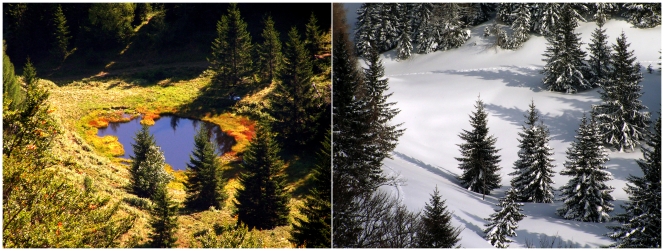
Shallow dystrophic Pond-1.This pond is persistently inhabited by the investigated Polynucleobacter lineage (F10 lineage). The images show the pond in autumn (left) and winter (right), when the pond is hidden below a thick ice and snow cover. The latter situation lasts for up to six months.